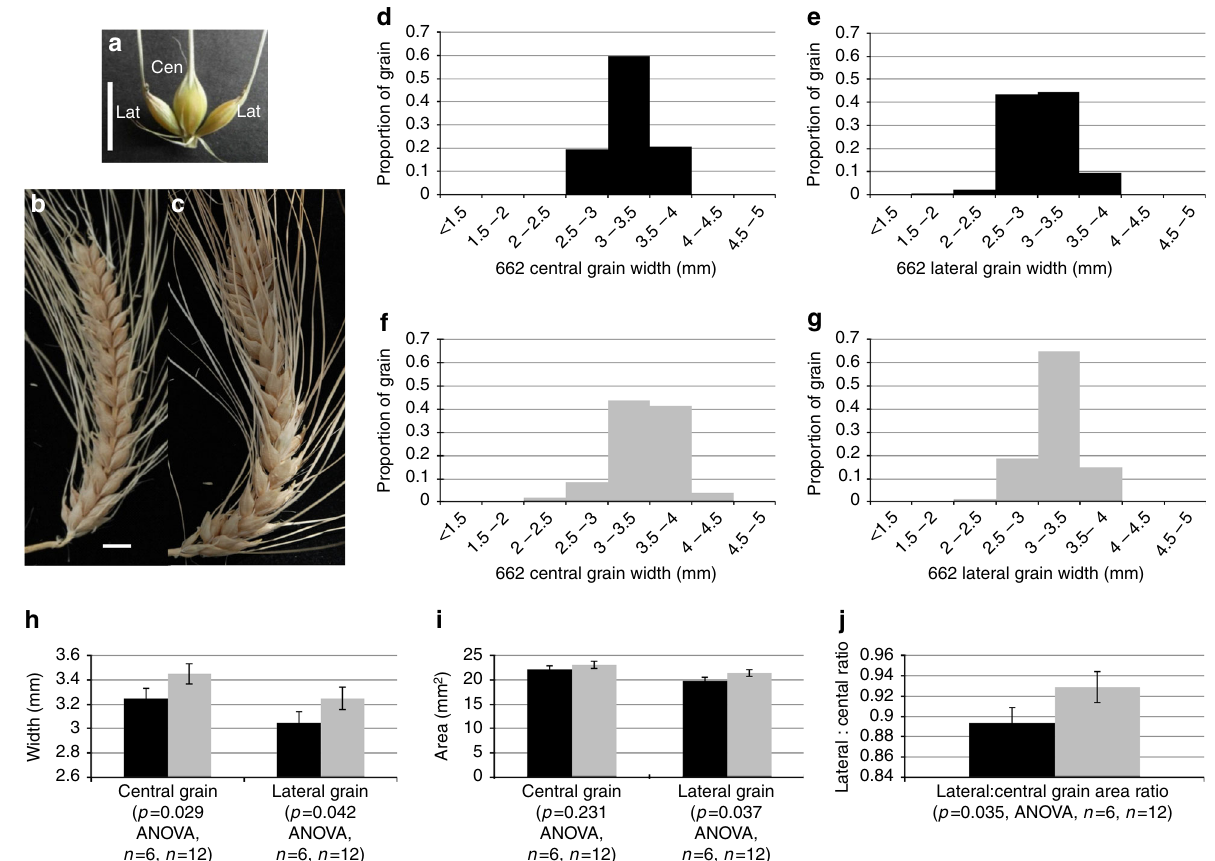
Fig. 5 Impact of vrs3 on grain size and uniformity in the six-rowed spike. a A typical six-rowed barley spikelet triplet ( vrs1 .a, Int-c .a, Vrs3 ) showing the central grain (Cen) fl anked by two lateral grain (Lat). Scale bar, 1 cm. b , c Six-rowed barley spikes from b the current commercial six-rowed genotype model: vrs1 .a, Int-c .a, Vrs3 .w (662) and c with the introduction of vrs3 : vrs1 .a, Int-c .a, vrs3 (666), respectively; Scale bar, 1 cm. d , e Distributions of d central and e lateral grain width fractions within the 662 genotypes. f , g Distributions of f central and g lateral grain width fractions within the 666 genotypes. h – j comparison of the mean grain width, grain area and lateral to central grain area ratio between the 662 ( n = 6) and 666 ( n = 13) genotype combinations; black bars: 662 genotype, grey bars: 666 genotype. Error bars are ± VRS3 sequence diversity . Reciprocal BLAST of rice LOC_Os10g42690 against the mismatch. For data analysis (Supplementary Fig. 7), raw data were checked for quality using FASTQC 0.11.3 and adaptors trimmed using Trimmomatic 0.30 47 . cv. Morex barley genome sequence identi fi ed Morex contig 5669 12,13 as containing the putative barley orthologue. Amplicons, generated with overlapping primer Transcript abundance was calculated using Salmon 0.7.2 48 , based on the barley transcript reference 12, 13 . Estimated read counts were summarised to gene level pairs were designed to amplify a region of 5815 bases from upstream of the using tximport 1.2.0 49 . Consistently lowly expressed genes were fi ltered out and the predicted start and downstream of the predicted stop (Supplementary Table 3), trimmed mean of M-values method (TMM) applied to normalise read counts using were Sanger sequenced using Big-Dye v3.1 (Applied Biosystems) across 22 cultivars representative of two-rowed and six-rowed, winter and spring haplotypes in the region of VRS3 (Supplementary Data 4). Vrs3 .w or Vrs3 .x alleles were dis- criminated in a further 220 spring and 255 winter cultivars using a single diagnostic KASP allele-speci fi c PCR (primers in Supplementary Data 2). Sequence variation in VRS3 in landraces and wild barley was obtained from the exome capture sequence groups identi fi ed DE genes 52 For the contrast groups, an empirical bayes moder- data described 19 . Accession geo-reference locations are provided in Supplementary ated t test was used to calculate the P values, these were further adjusted to account Data 5 and Vrs3 haplotypes in Supplementary Data 6. A median-joining tree was constructed using PopArt network software (http://popart.otago.ac.nze). GOEAST 54 . Selected transcripts were validated by qRT-PCR in independent experiments (Supplementary Fig. 5 and Supplementary Note). Gene expression analyses . For RNA-seq, following germination in 96-well trays, For qRT-PCR, RNA was extracted from developing in fl orescences ( n = 3, 24 Bowman WT and BW902( vrs3 .f) seedlings were transferred to 8.89 cm pots plants per rep, according to MIQE guidelines for sample replication 55 ) at 1mm, arranged in a randomised block design. For each biological rep ( n = 8, providing 2 – 3mm and 10mm length using an RNAeasy Plant Mini Kit (QIAGEN). cDNA > 98% statistical power 46 ), 20 – 25 AP stage (AP, 5 mm ± 1mm spike length) or was synthesised from 2 μ g of RNA using Ready-To-Go You-Prime First-Strand 10 – 15 spikes at WA stage (10 mm ± 1mm spike length) were collected off the main shoot within a constant 3 h window in the light period. Total RNA was extracted with TRIzol Reagent (Invitrogen), treated with DNase (QIAGEN) and puri fi ed Library (Roche) hydrolysis probes. Expression was normalised to the ACT2 or PDF2 with RNeasy columns (QIAGEN). Stranded RNAseq libraries were prepared with reference using the 2 − Δ CT method. Signi fi cant differences were calculated using a the NEXT fl ex ™ Rapid Directional RNA-Seq Kit with NEXT fl ex ™ DNA Barcodes Student ’ s t -test (two-tailed). qPCR primers are listed in Supplementary Table 4 and (Bioo Scienti fi c, manual v 14.09) using 1 µ g total RNA of each sample to generate a parameters in Supplementary Note. The 16 tissue RNA-seq Expression Atlas library using NEXT fl ex ™ beads. Libraries were normalised, pooled (6 libraries per (FPKM values) is available in the BarleyGenes database b (Supplementary Note). lane of sequencing) at equimolar concentrations and diluted to 10 pM. Pools were clustered with the HiSeq Rapid PE Cluster Kit v2 (Illumina) and sequenced on a SEM and in situ hybridisation . For SEM samples, spikes at AP stage were pre- HiSeq2500 (Illumina). Each library pool was run in a single lane as paired-end 2× 150 bp. Reads were demultiplexed using CASAVA 1.8, allowing a one base-pair pared and imaged as described 56 . Spikes collected at early lemma and AP stages